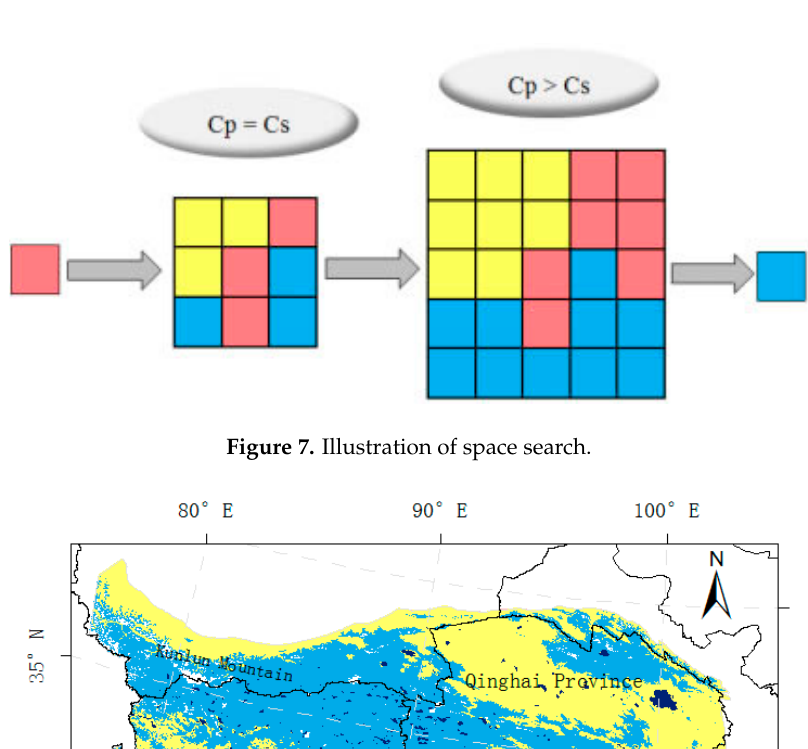
10 of 19 Figure 6. Classification Process Based on Decision Tree Method: ( a ) preliminary classification by elevation; ( b ) further classification by adding LST based on elevation; ( c ) further classification by adding NDVI based on elevation and LST; ( d ) classification by four indicators (elevation, LST, NDVI and soil moisture). The First Law of Geography, according to Waldo Tobler [56], reads “everything is related to everything else, but near things are more related than distant things.” This theory is also applicable to permafrost, if the number of permafrost pixels (Cp) adjacent to an uncertain pixels is greater than the number of seasonally frozen ground pixels (Cs), then those uncertain pixels are classified